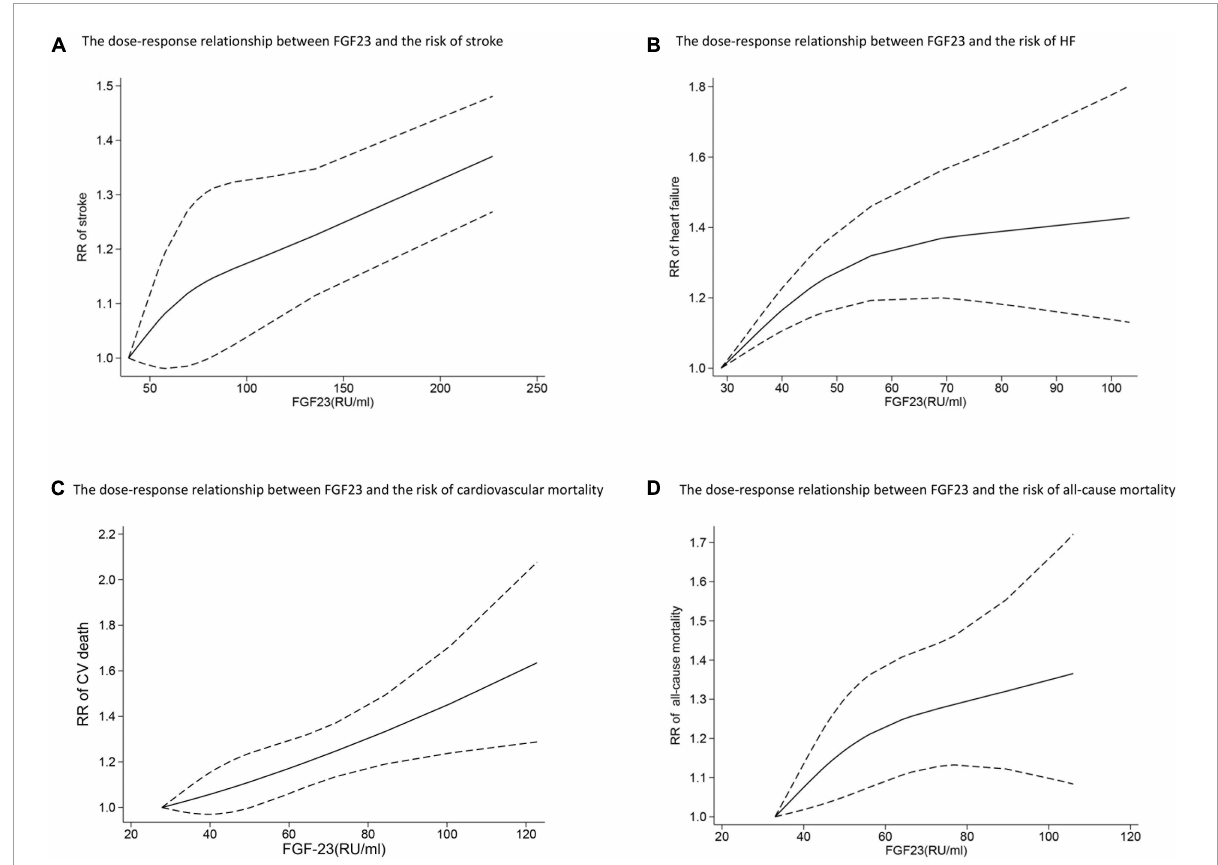
FIGURE3 The dose-response relationship between FGF23 levels and the risk of stroke (A) , HF (B) , cardiovascular mortality (C) , and all-cause mortality (D) in the general population. FGF23 levels were converted to RU/ml and the results were pooled in a one-stage random-effects model. The bold lines indicate the pooled restricted cubic spline model and the black dashed line indicates the 95% CIs of the pooled